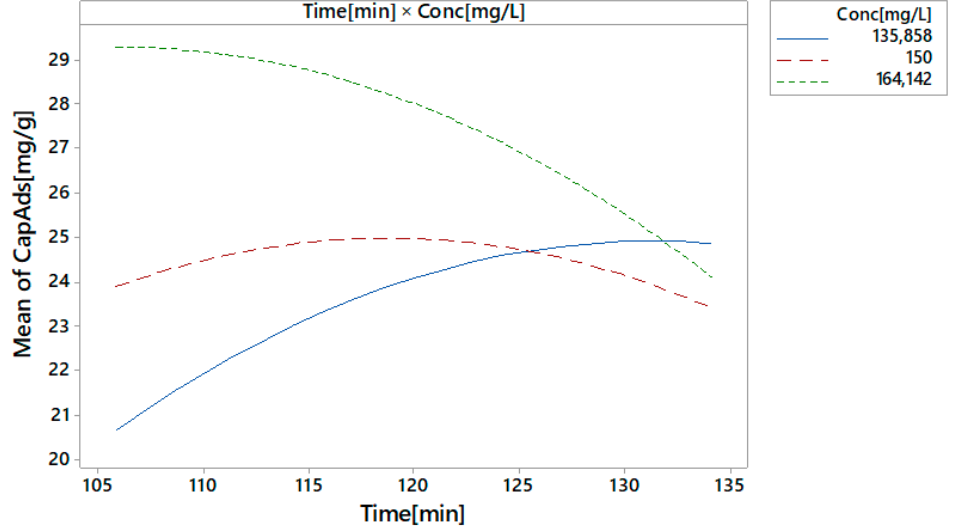
Figure 11. The contact time–initial concentration interactions. The curves for the initial gold concentration of 150 and 164 mg/L are almost parallel and horizontal, which means that the contact time–initial concentration interaction does not have a significant effect. It is observed that there are slight interactions between the initial concentration of 136 mg/L and that of 150 mg/L. The interactions do not mask the main